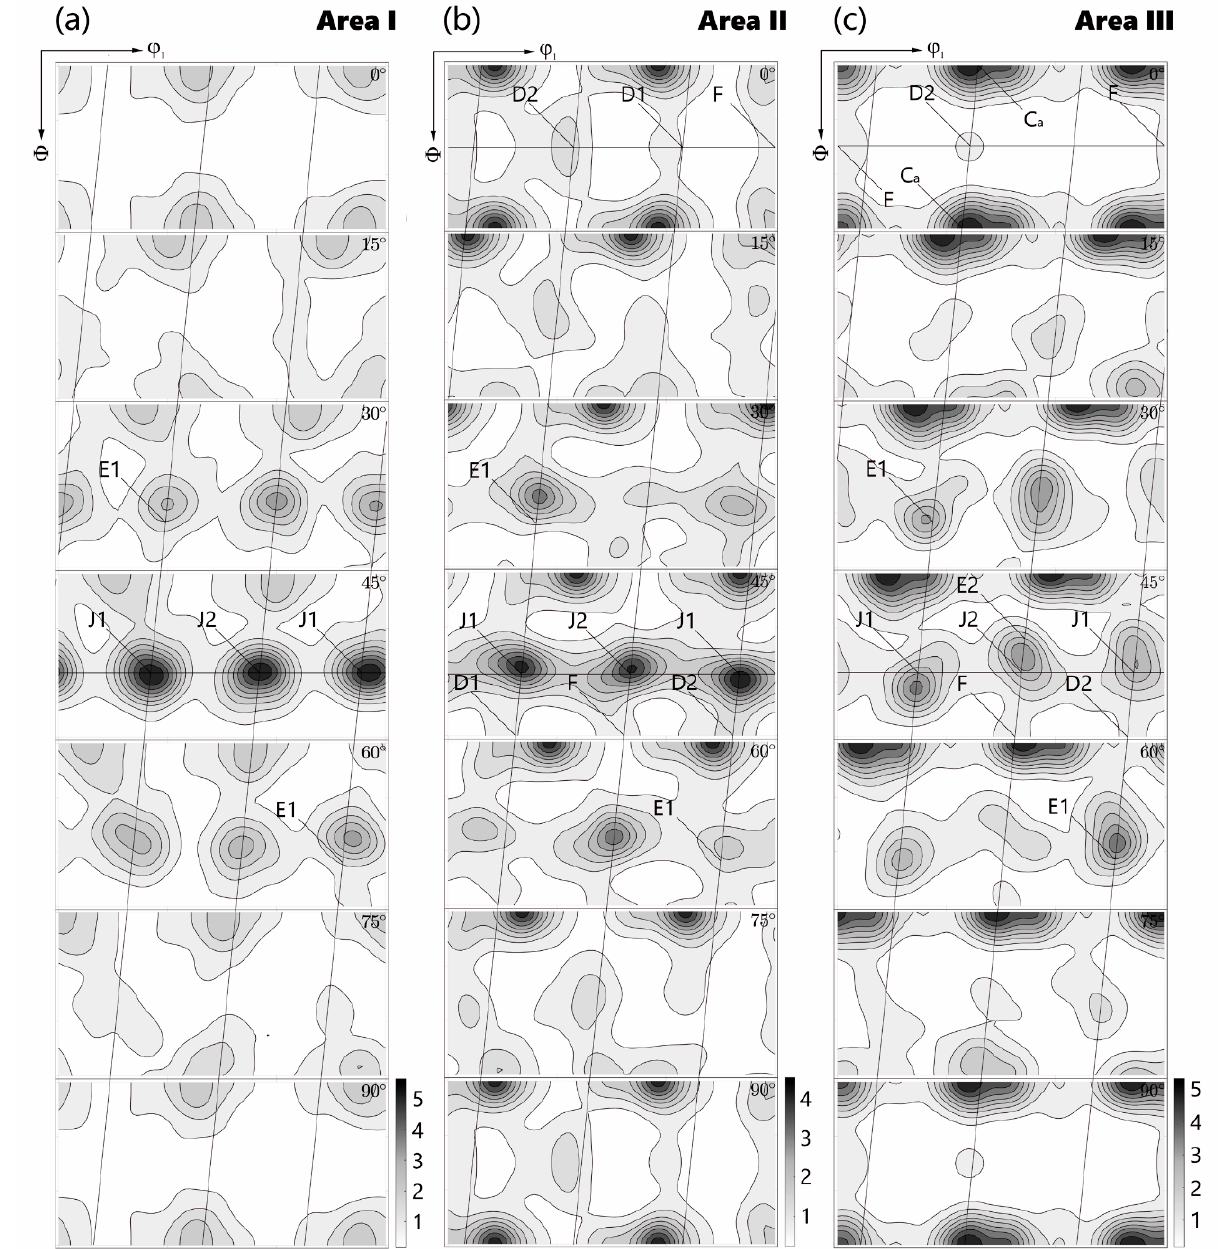
Figure 2. Euler sections to visualize ODF in ( a ) Area I, ( b ) Area II, and ( c ) Area III with monoclinic symmetry.